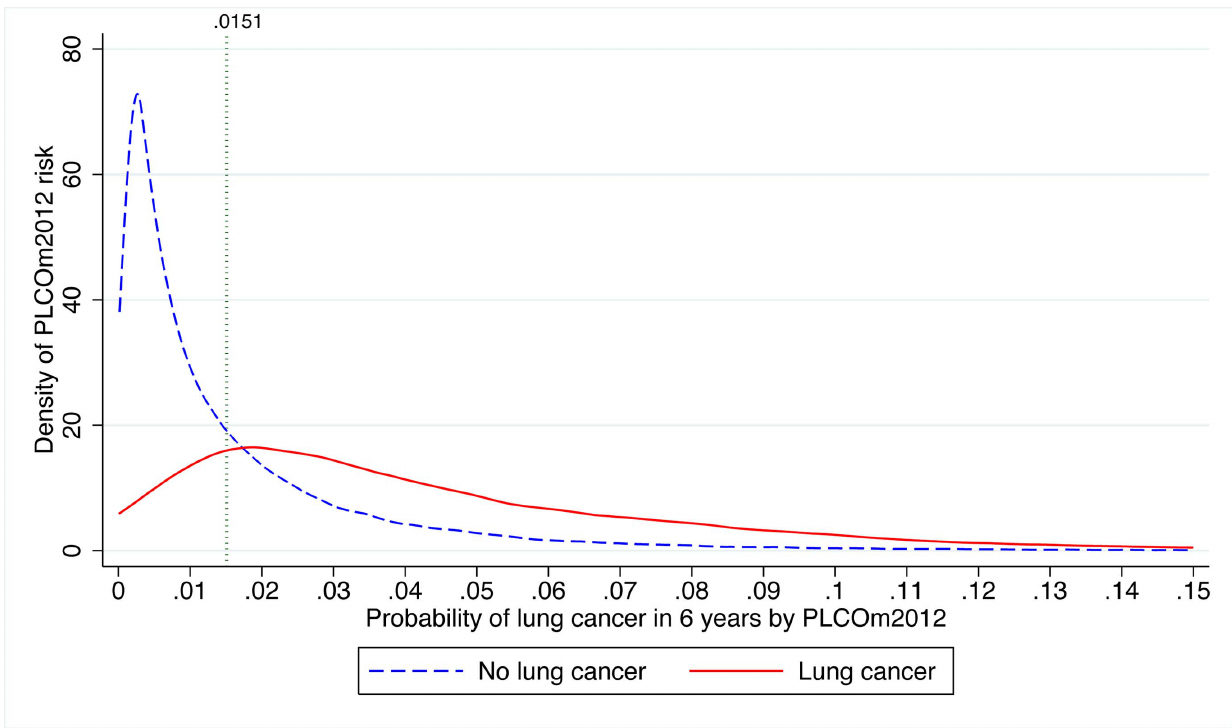
Figure 6. Distribution of PLCO m2012 risk in PLCO intervention arm smokers with and without lung cancer diagnosed in 6 y of follow- up. The risk threshold p= 0.0151 is indicated by the vertical line. The graph is right-truncated. PLCO m2012 is the lung cancer risk prediction model described in [11].